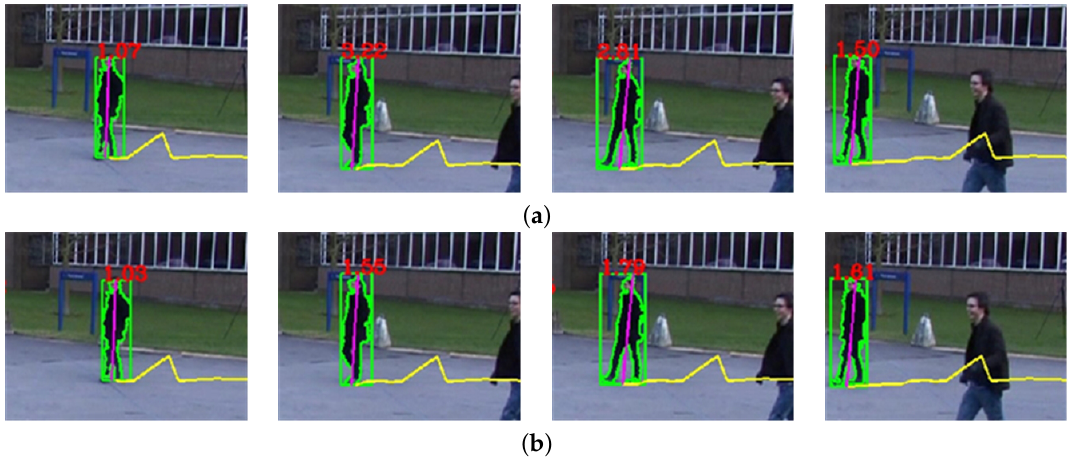
Figure 12. Results of object speed estimation: ( a ) without using the Kalman filter and ( b ) using the Kalman